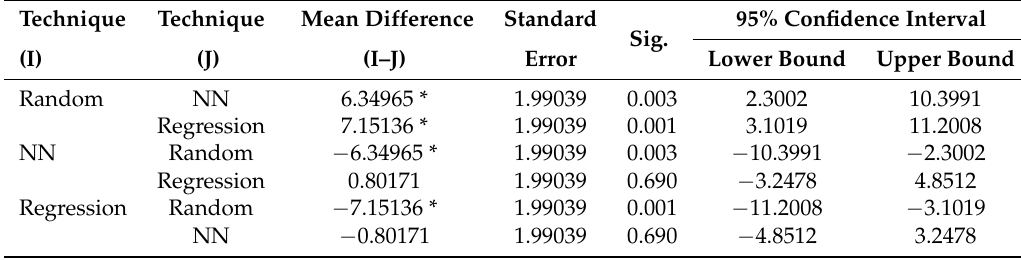
Table 17. LSD: Multiple Comparisons (Random, NN and Regression) significant with respect to final solution. Here * denotes that the mean difference is significant at the 0.05